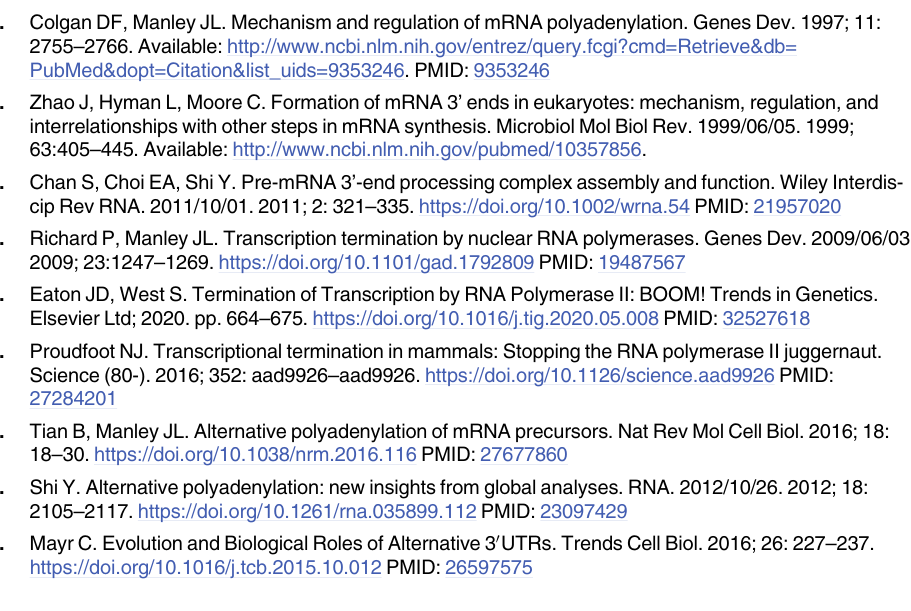
S6 Fig. Ribo-seq tracks for example genes (related to Fig 6A). Lactimidomycin is a transla- tion